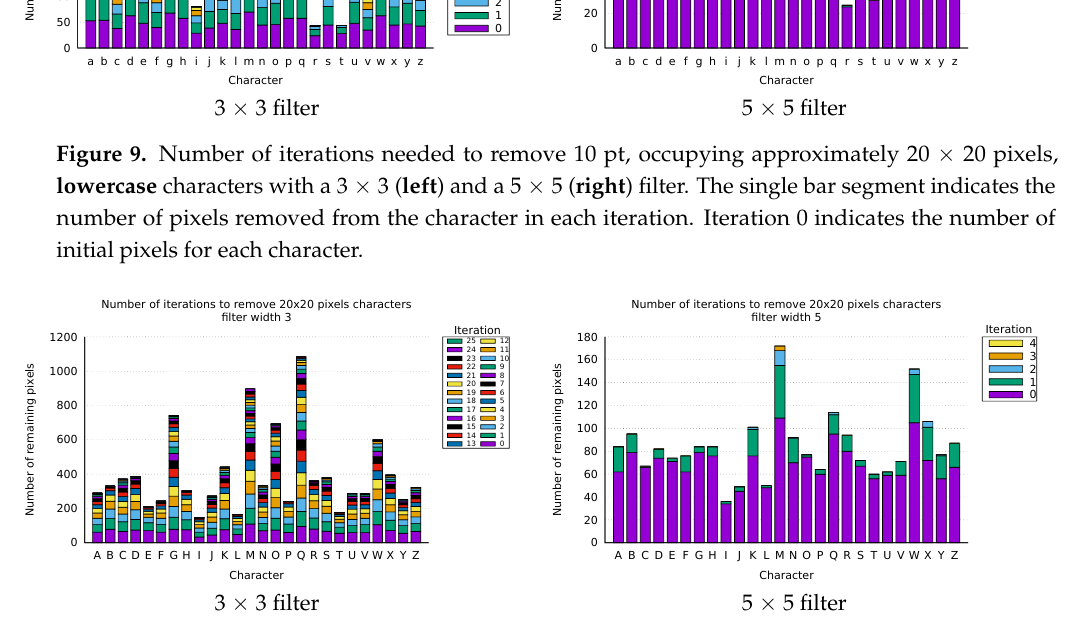
Figure 10. Number of iterations needed to remove 10 pt, occupying approximately 20 × 20 pixels, uppercase characters with a 3 × 3 ( left ) and a 5 × 5 ( right ) filter. The single bar segment indicates the number of pixels removed from the character in each iteration. Iteration 0 indicates the number of initial pixels for each